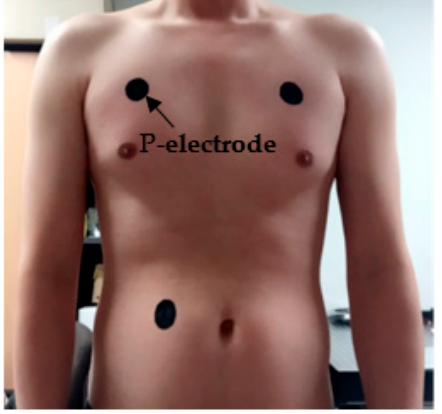
Figure 8. Application of P-electrodes on the subject’s body.